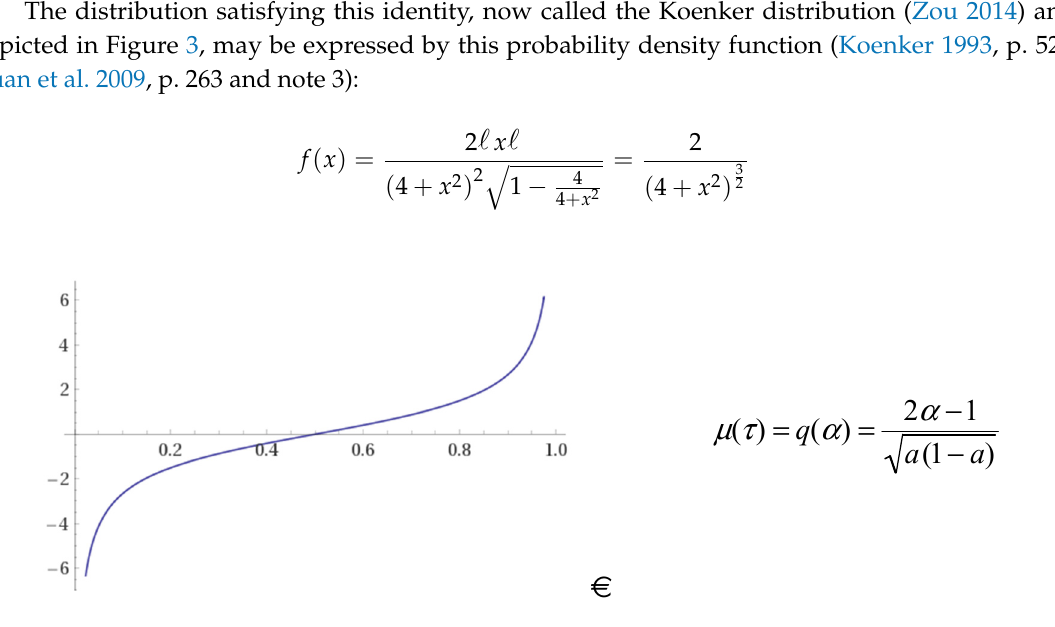
Figure 3. Identical expectile and quantile functions for the Koenker distribution.